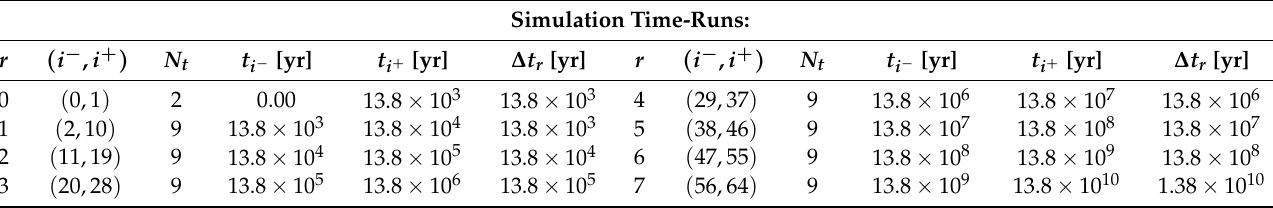
Table 2. The N r = 7 time-runs, denoted by the index r = 1,2, . . . ,7, into which each realisation is partitioned for a total of N t = 64 marked by the index i = i i = i − = 1,2, . . . ,7 and the number of non-overlapping time slices in each run, as well as the initial time, ending time and time-step factored by the present age of the Universe, t 64 = 13.8 × 10 10 yr, which corresponds to the current age of the Universe t U = ( 13.800 ± 0.024 ) × 10 10 yr according to Planck 2018 (TT, TE, EE+lowE, see Ref. [6]). The time intervals and time-slices shown in Figure 7, displaying the PBHs positions and velocities at each of